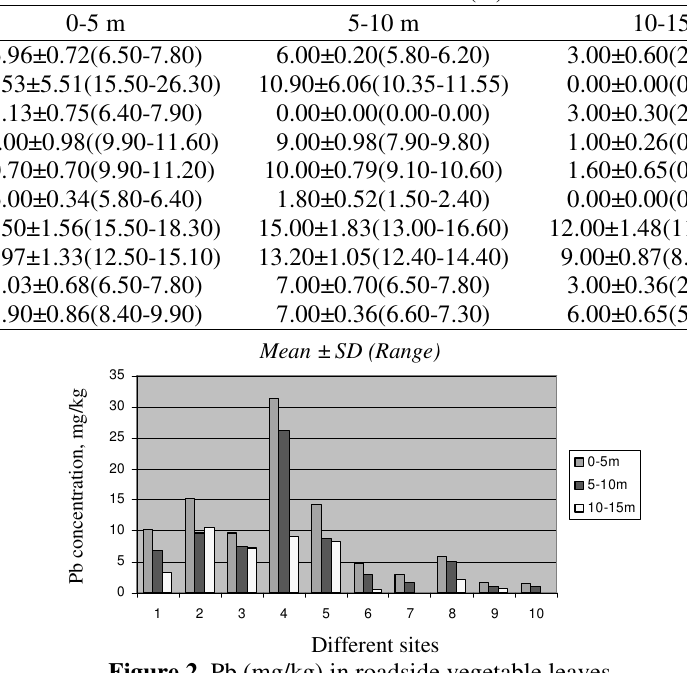
Figure 2. Pb (mg/kg) in roadside vegetable leaves